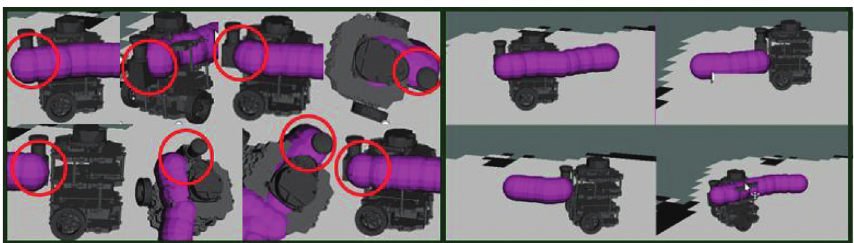
Figure 11: The positioning effects for mobile robot moving along different tracks with different speeds of VLP-based robot system.